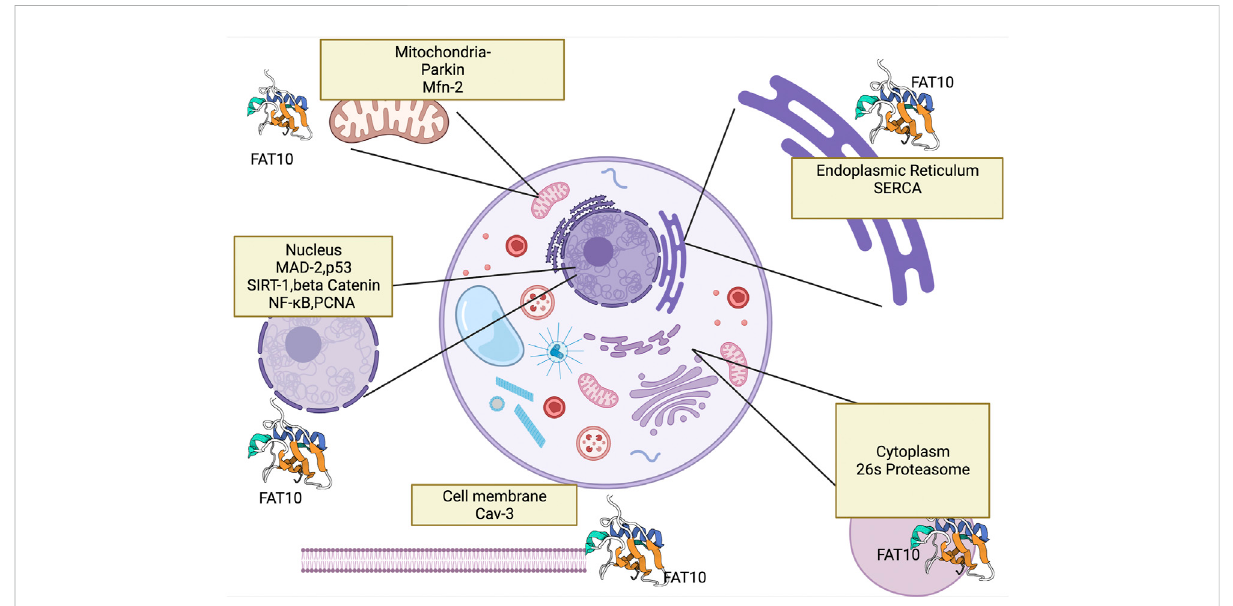
This fi gure shows FAT10 ’ s interaction with cell organelles and with genes that FAT10 binds. Here we show FAT10 interactions with nucleus (Ramos et al., 2021), (Li et al., 2011) mitochondria (Roverato et al., 2021), cytoplasm (Jia et al., 2020), endoplasm reticulum (Buchsbaum et al., 2012) and cell membrane which may contribute to liver disease development. The fi gure created by Biorender.com (Accessed on 22nd of March